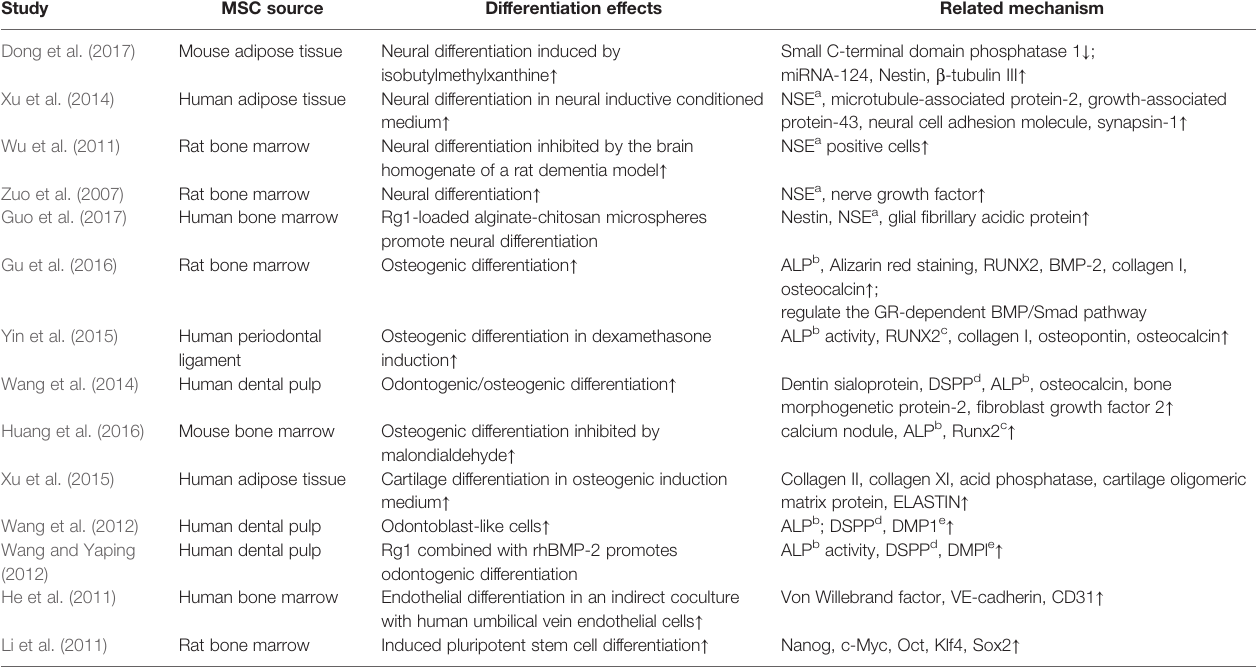
TABLE 2 | Ginsenoside Rg1 promotes the directional differentiation of MSCs in vitro